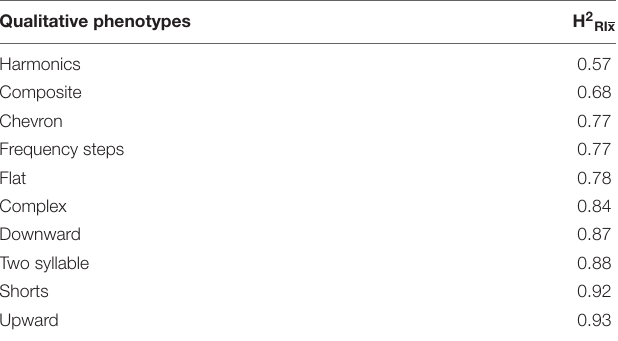
TABLE 2 | H 2 RIx estimates for qualitative ultrasonic vocalization traits in the B6/D2 diallel cross. Qualitative